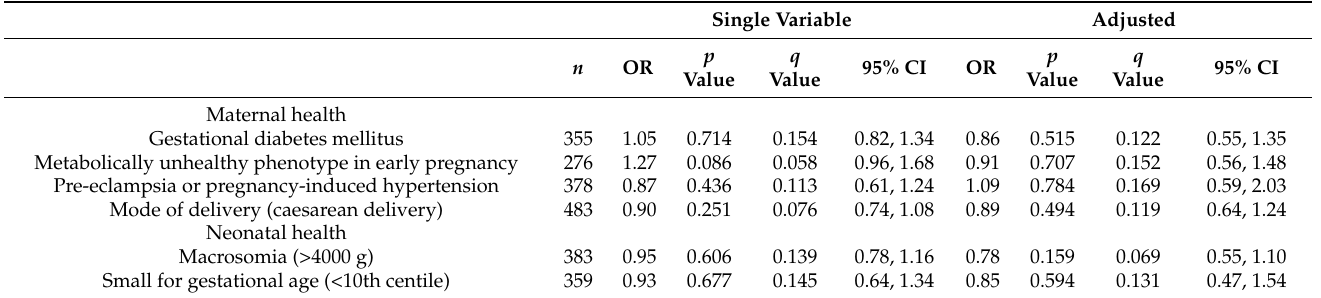
Table 5. Multiple logistic regression models for E-DII TM associations with maternal and foetal